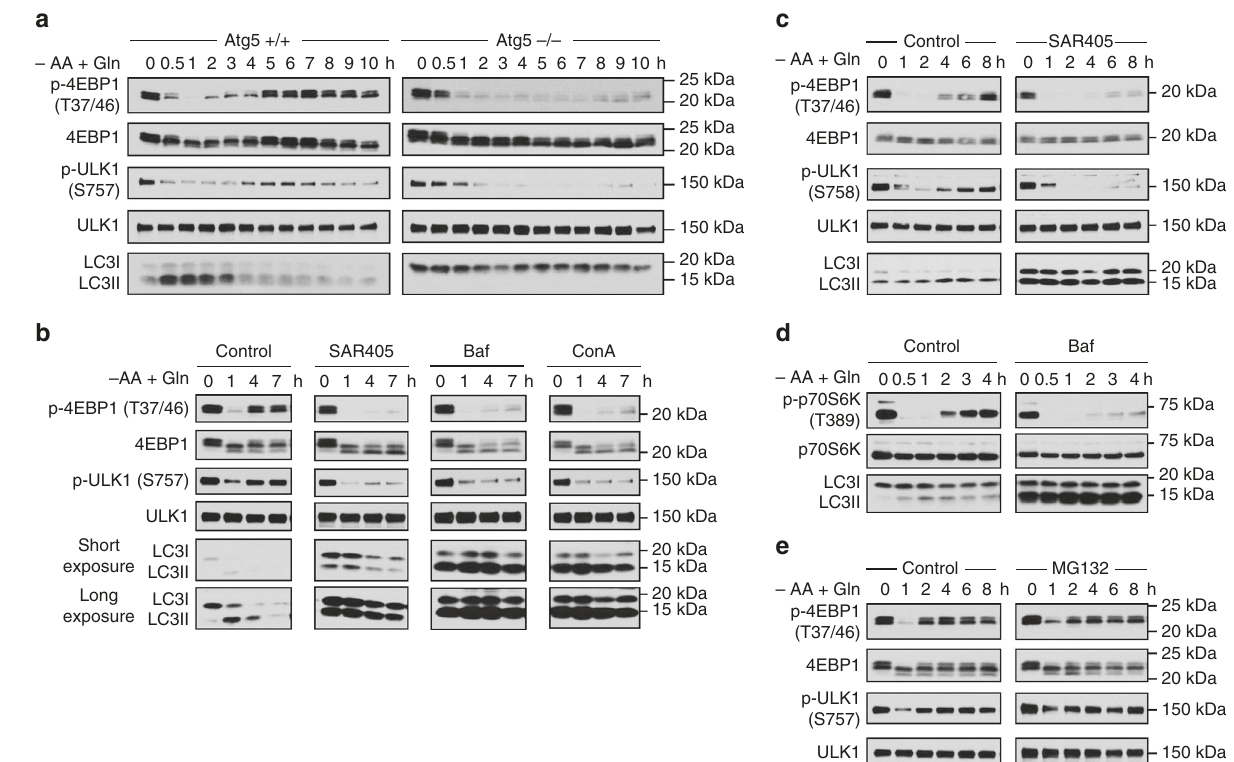
Fig. 2 Autophagy is essential for glutamine-dependent restoration of mTORC1 signaling. a Wild-type ( Atg5 +/+) or Atg5 -knockout ( Atg5 − / − ) MEFs were subjected to amino acid starvation in the presence of glutamine (4 mM) for the indicated durations. b Wild-type MEFs were deprived of amino acids with the supplementation of glutamine (4 mM) for the indicated durations. Ba fi lomycin A1 (Baf, 200 nM), concanamycin A (ConA, 100 nM) or SAR405 (SAR, 5 µ M) was added to inhibit autophagy. Changes in mTORC1 activity or autophagy were assessed by immunoblotting of p-4EBP1 and p-ULK1, or LC3, respectively. c , d HepG2 cells and C2C12 mouse myotubes were starved of amino acids as in b for the indicated durations. SAR405 (5 µ M) and ba fi lomycin A1 (200 nM) was added to inhibit autophagy in HepG2 cells and C2C12 myotubes, respectively. Changes in mTORC1 activity were assessed by immunoblotting of p-4EBP1 and p-ULK1 (for HepG2 cells) or p-p70S6K (for C2C12 myotubes), and changes in autophagy was evaluated by immunoblotting of LC3. e Wild-type MEFs were deprived of amino acids with the supplementation of glutamine (4 mM) for the indicated durations. MG132 (10 µ M) was added to inhibit proteasome function. Changes in mTORC1 activity were assessed by immunoblotting of p-4EBP1 and